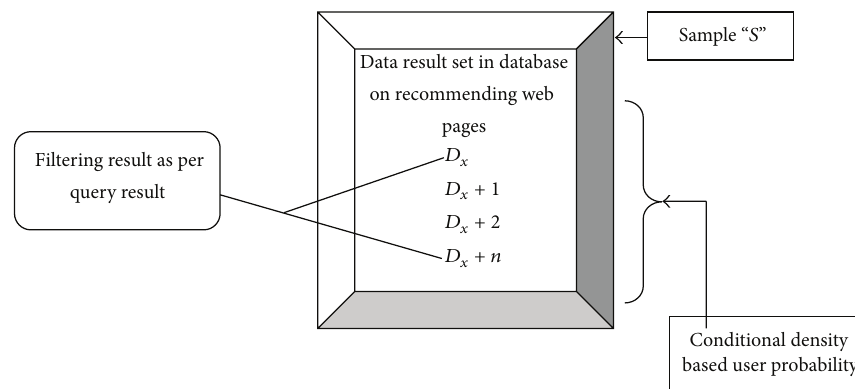
Figure 3: Diagrammatic form of Hamilton’s filtering